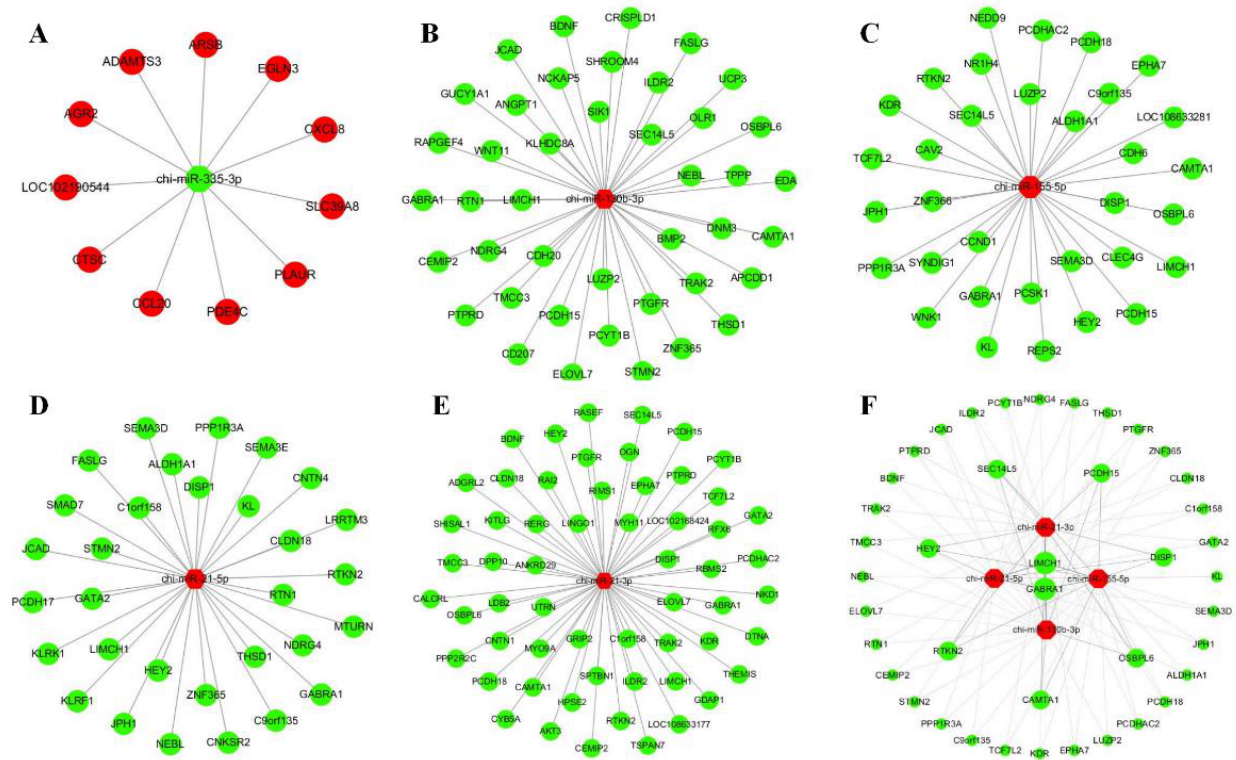
Figure 8. The regulatory networks of target differential expression genes and miRNAs. ( A – E ) shows the five common differentially expressed miRNAs–targets gene network (chi–miR–335–3p, chi–miR130b–3p, chi–miR–155–5p, chi–miR–21–5p and chi–miR–21–3p), respectively. ( F ) shows the target genes were commonly targeted by two, three or four up-regulated miRNAs. Red and blue represent up–and down–regulated genes or miRNAs, hexagons and circles indicate the differentially expressed miRNA and mRNA molecules, respectively.